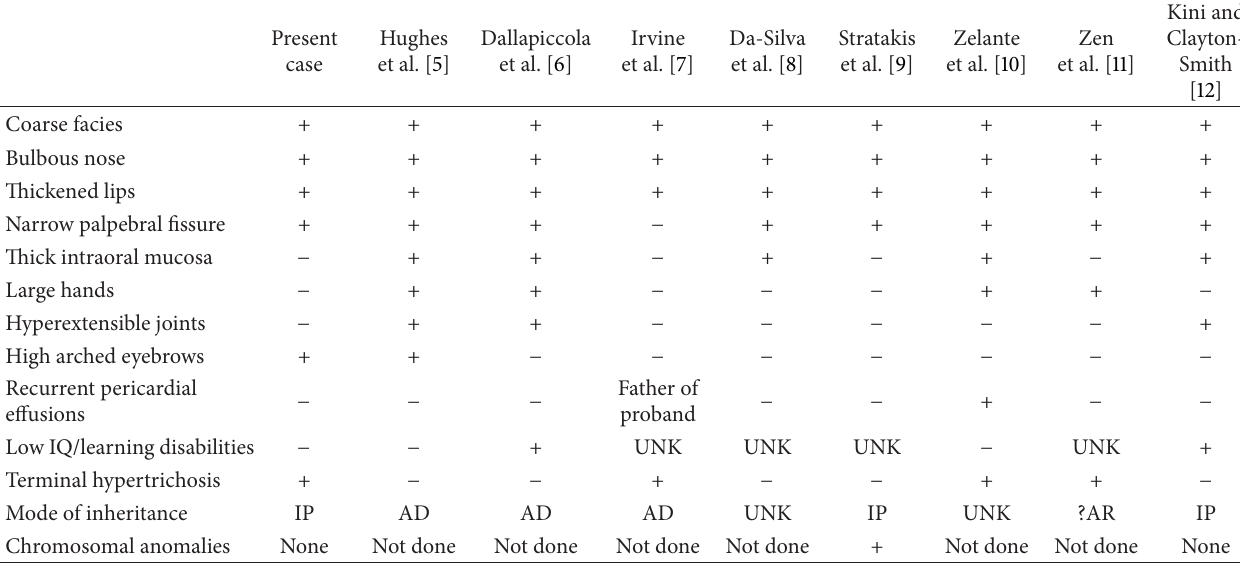
Table 2: A review of the reported cases/families with AFA.